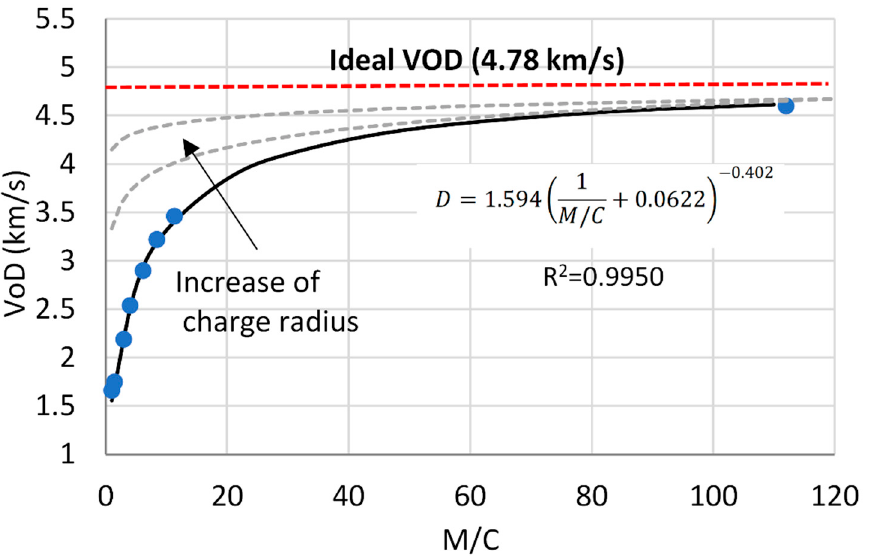
Figure 5. Influence of M / C on VoD . Note: Dashed lines represent the anticipated trend in VoD – M / C curves for larger charge diameters [1].